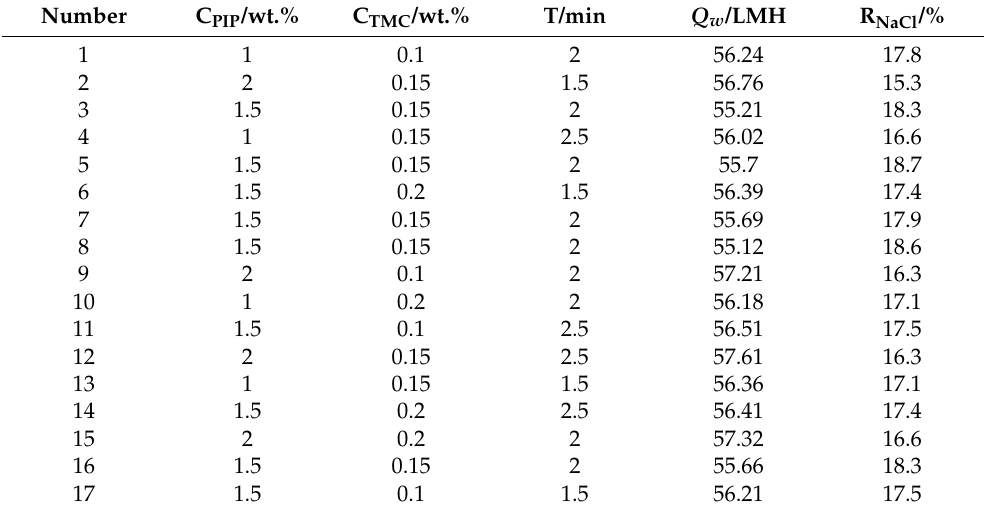
Table 2. Results of orthogonal experiments.